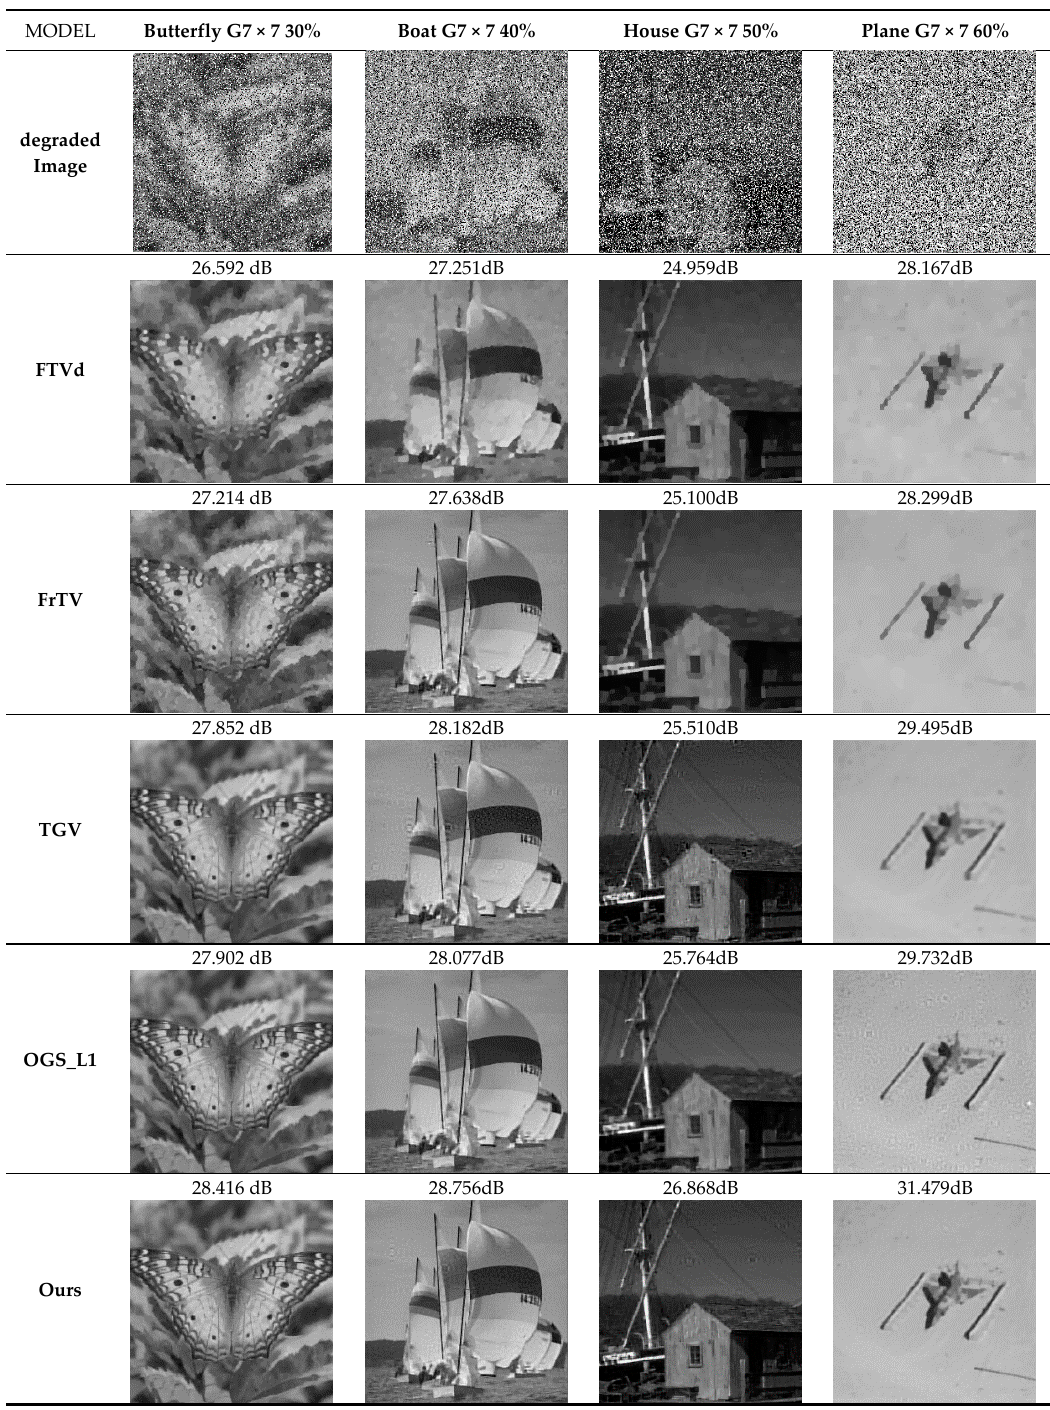
Figure 7. Random examples of images reconstructed by several advanced models and proposed model. Top row depicts the blurred and noisy images of the butterfly, boat, house, and plane owing to convolution with a G 7 × 7, σ = 5 blur kernel and impulse noise levels of 30%, 40%, 50%, and